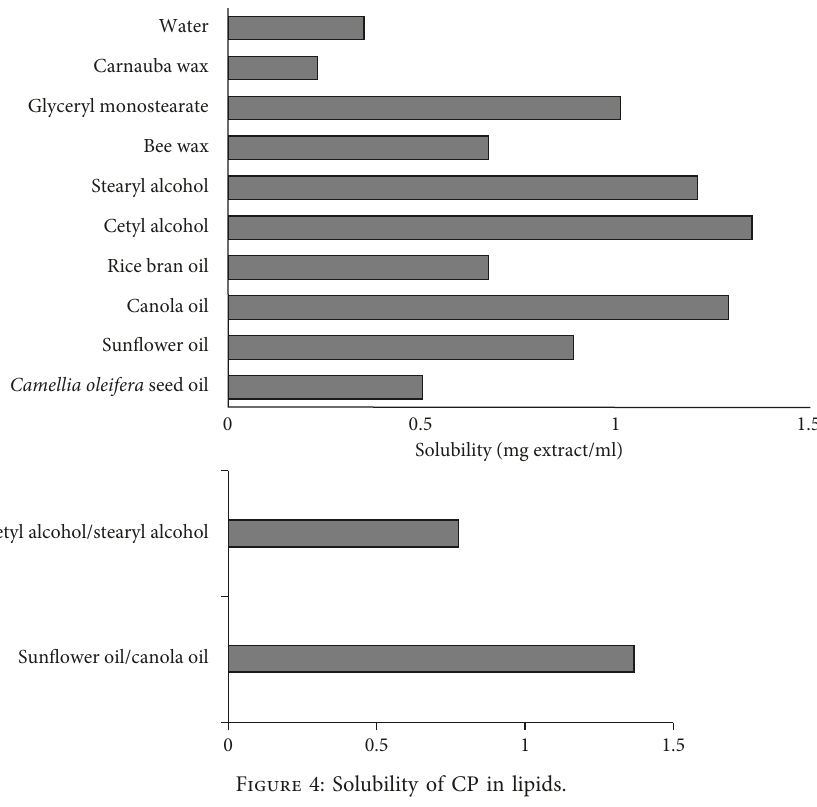
Figure 4: Solubility of CP in lipids.